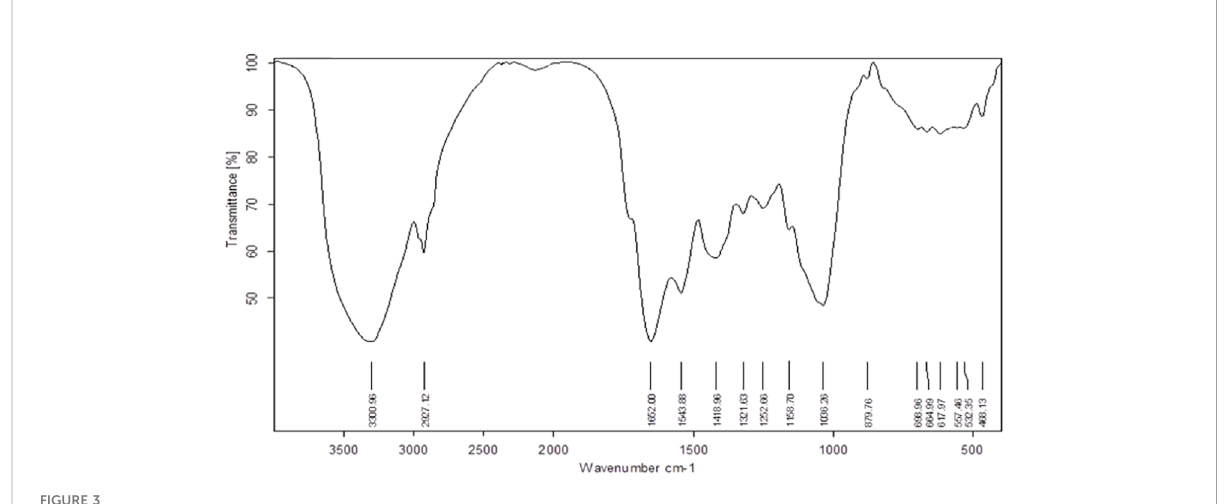
FIGURE 3 FTIR spectra of